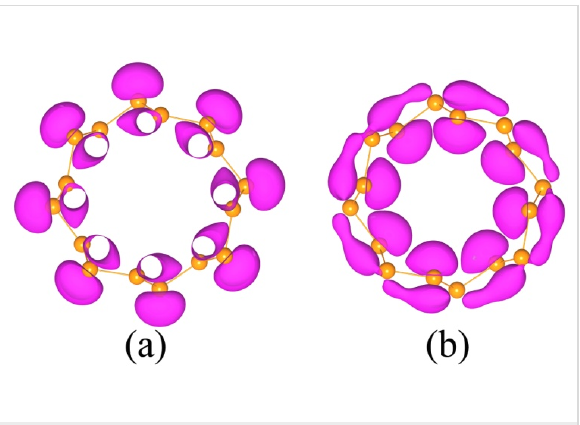
Figure 3: Charge density of the last valence band (a) and the first conduction band (b) of (4,4) SiNT at the k point at which point direct transitions occurrs (see arrow in Figure 2a).